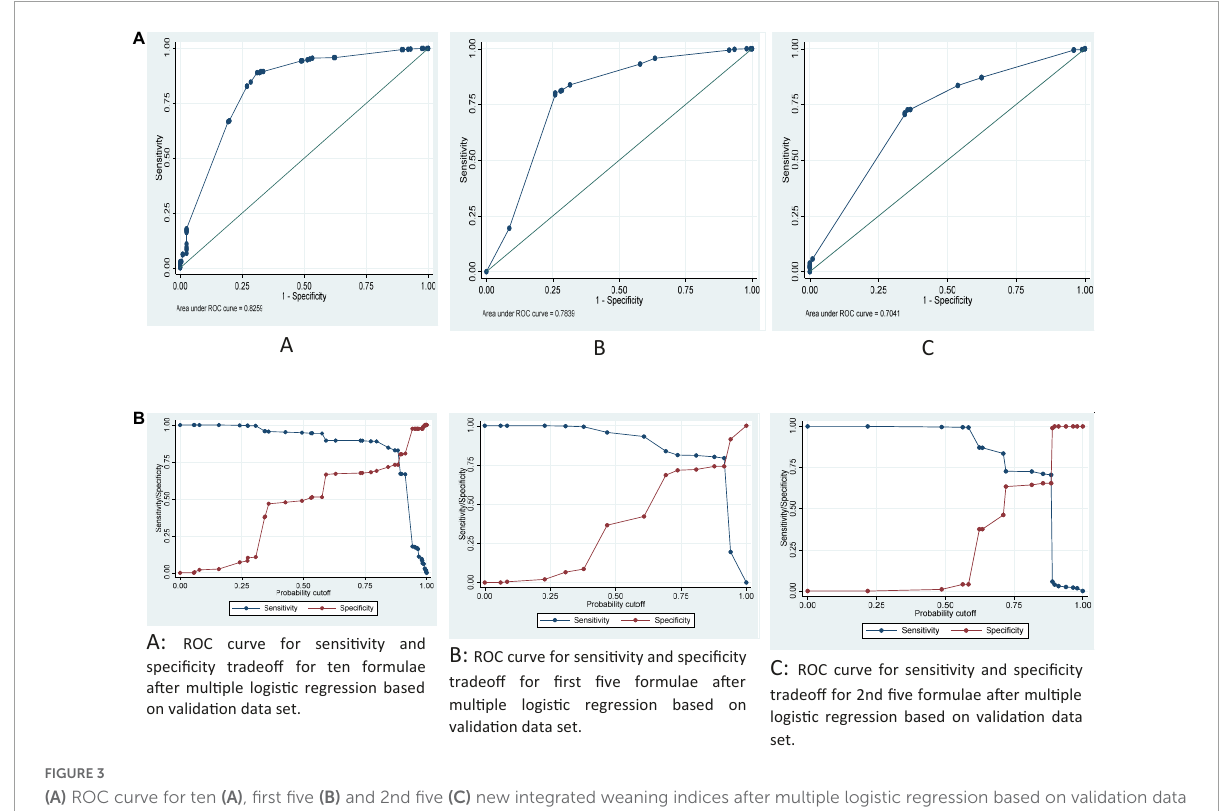
FIGURE3 (A) ROC curve for ten (A) , first five (B) and 2nd five (C) new integrated weaning indices after multiple logistic regression based on validation data set. (B) ROC curve for sensitivity and specificity tradeoff for ten (A) , first five (B) , and 2nd five (C) new integrated weaning indices after multiple logistic regression based on validation data